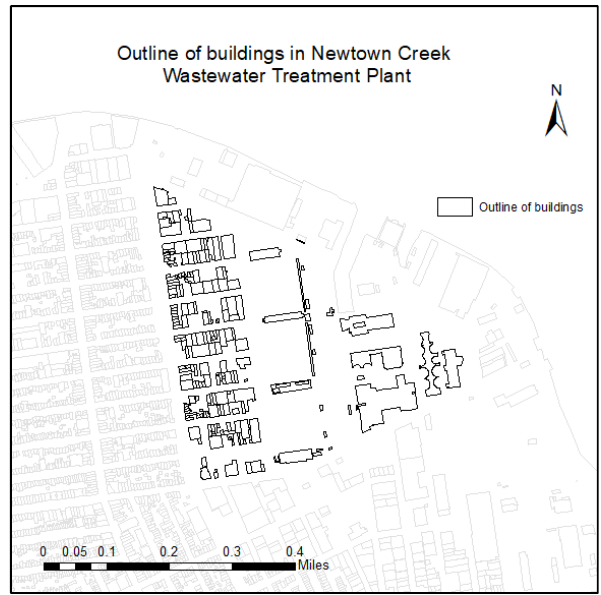
Figure 4. Outline of buildings in Newtown Creek WWTP. Table 4. Percentage of the submerged length and maximum flood depth for Newtown Creek WWTP and amount of damage in three events.